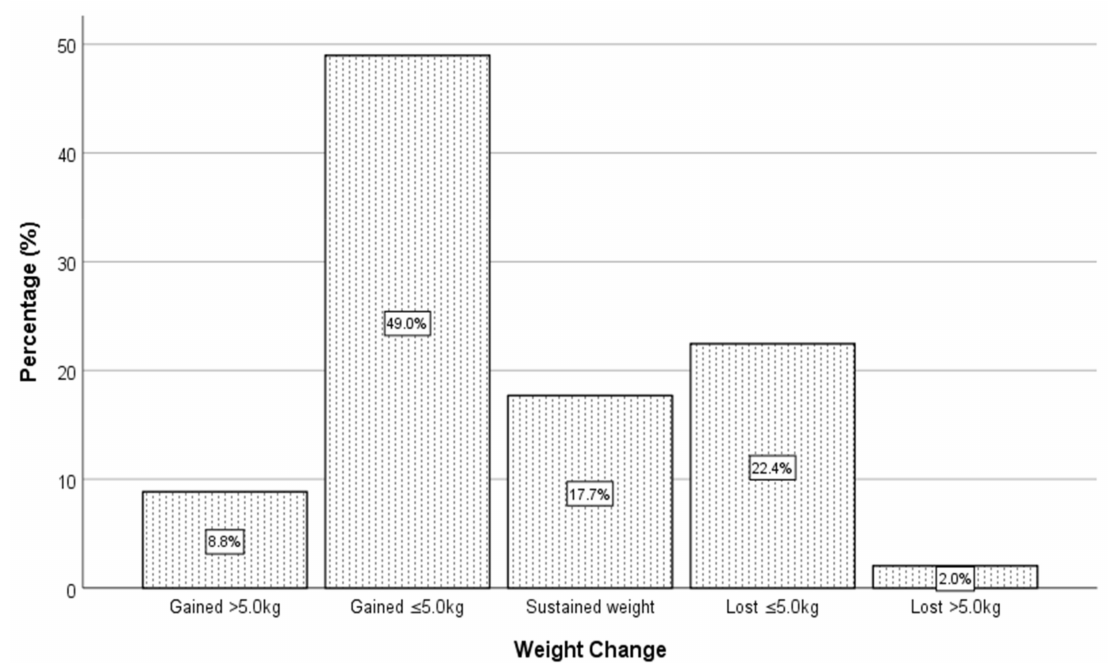
Figure 1. Weight change among Malaysian students during the COVID-19